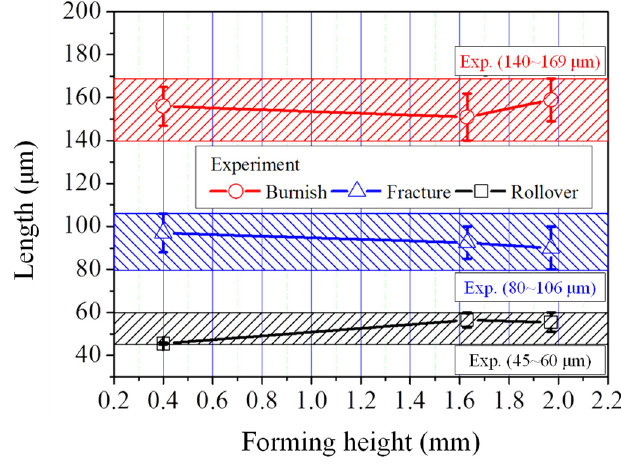
Figure 5. Variation of lengths in slitting plane according to forming height.